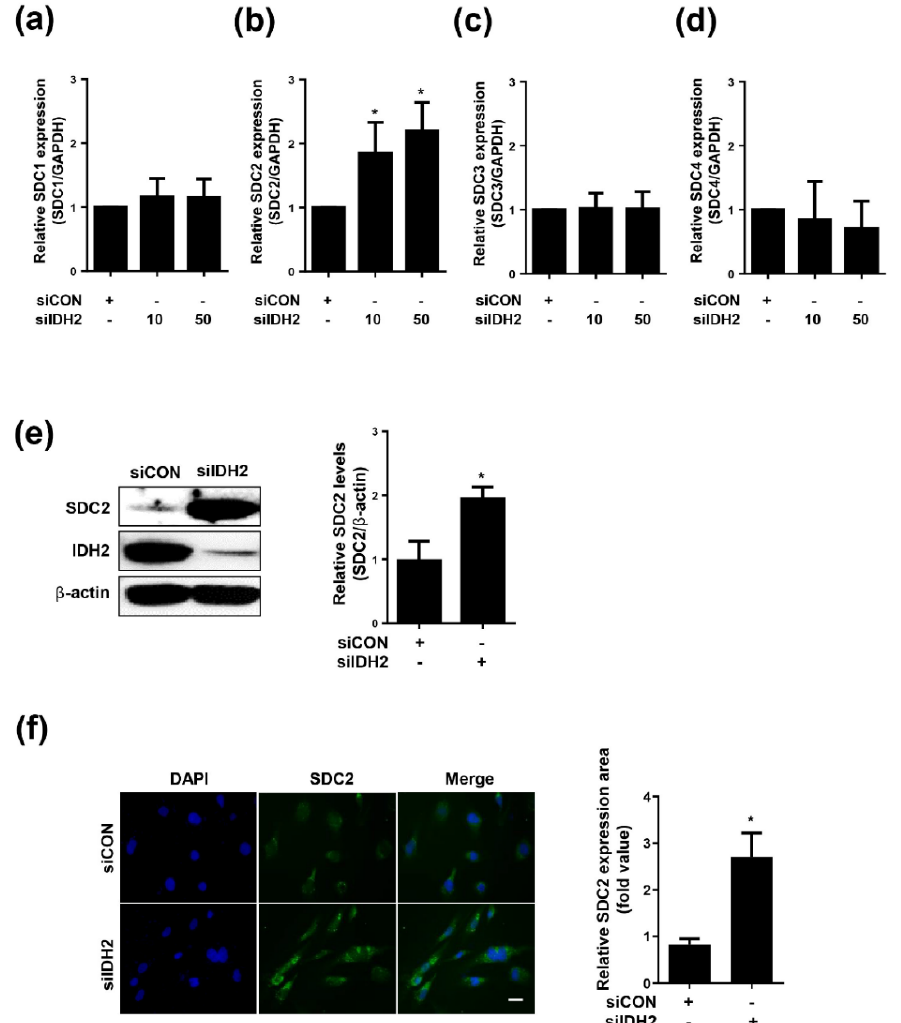
Figure 1. Expression of Syndecans in IDH2 deficient HUVECs. HUVECs were transfected with dose dependent siIDH2 (10 pmol, 50 pmol) and siCON for 48h. mRNA expressions of ( a ) SDC1, ( b ) SDC2, ( c ) SDC3, ( d ) SDC4 were quantified by qPCR ( e ) protein level of SDC2 was detected by western blotting. β -actin was used as a loading control. Protein levels were quantified by densitometric analysis using Image-J software (Shown in the right panel). ( f ) Immunofluorescence analysis of HUVECs to compare the SDC2 expression in siCON and siIDH2 (50 pmol) transfected HUVECs (scale bar 100 μm). All data are presented as means ± SEM of three independent experiments, * p < 0.05, compared with siCON.